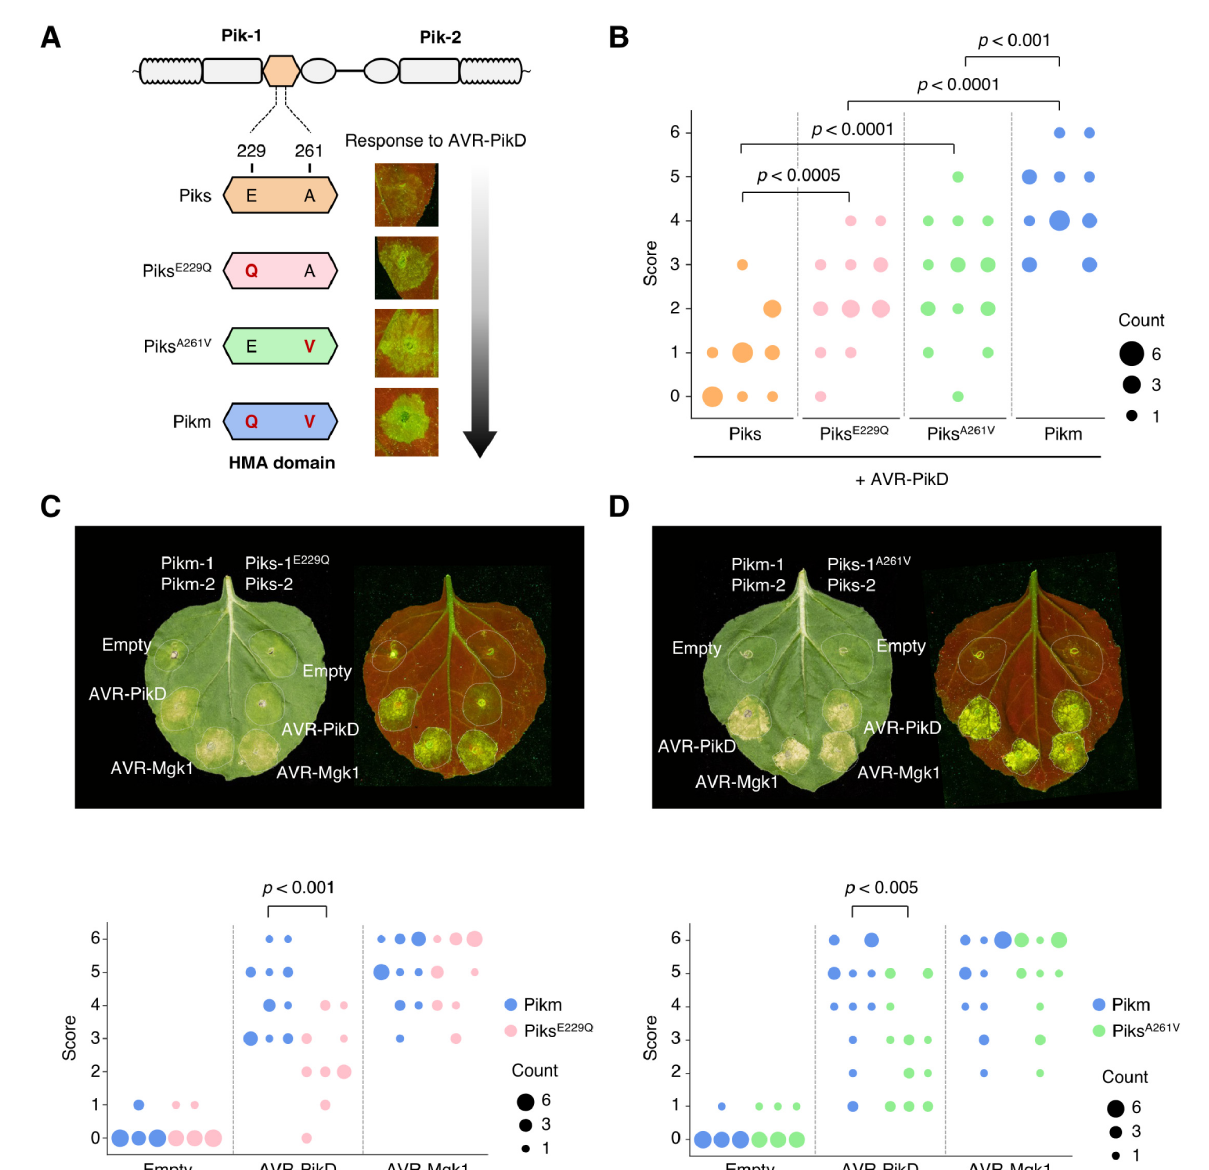
Fig 8. The polymorphisms (E229Q and A261V) between Piks and Pikm quantitatively affect the response to AVR-PikD. (A) Schematic representations of single amino acid mutants (Piks E229Q and Piks A261V ) used in the HR cell death assay in N . benthamiana with AVR-PikD. (B) We quantified HR scores of Piks (Piks-1/Piks-2), Piks E229Q (Piks-1 E229Q /Piks-2), Piks A261V (Piks-1 A261V /Piks-2), or Pikm (Pikm-1/Pikm-2) with AVR-PikD 5–6 days after agroinfiltration and statistically significant differences are indicated (Mann–Whitney U rank test). Piks-2 and Pikm-2 are identical. (C) HR cell death assay with Piks E229Q and AVRs. (D) HR cell death assay with Piks A261V and AVRs. The leaves were photographed 5–6 days after infiltration under daylight (left) and UV light (right). We quantified the HR at 5–6 days after agroinfiltration and statistically significant differences are indicated (Mann–Whitney U rank test). Each column represents an independent experiment. The data underlying Fig 8B – 8D can be found in S1 Data . AVR, avirulence; HR, hypersensitive